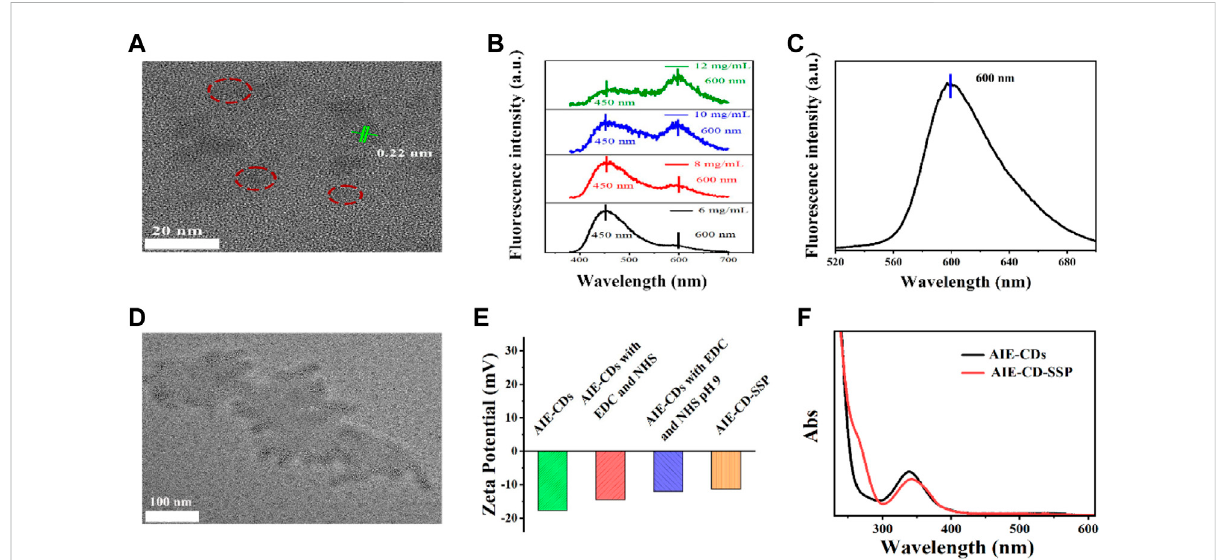
FIGURE 2 (A) Transmission electron microscope (TEM) image and the lattice pattern of AIE-CDs. (B) (C) Fluorescence spectrogram of original AIE-CDs undertheexcitationwavelengthat365nmand500nm. (D) TEMimageofAIE-CD-SSP. (E)